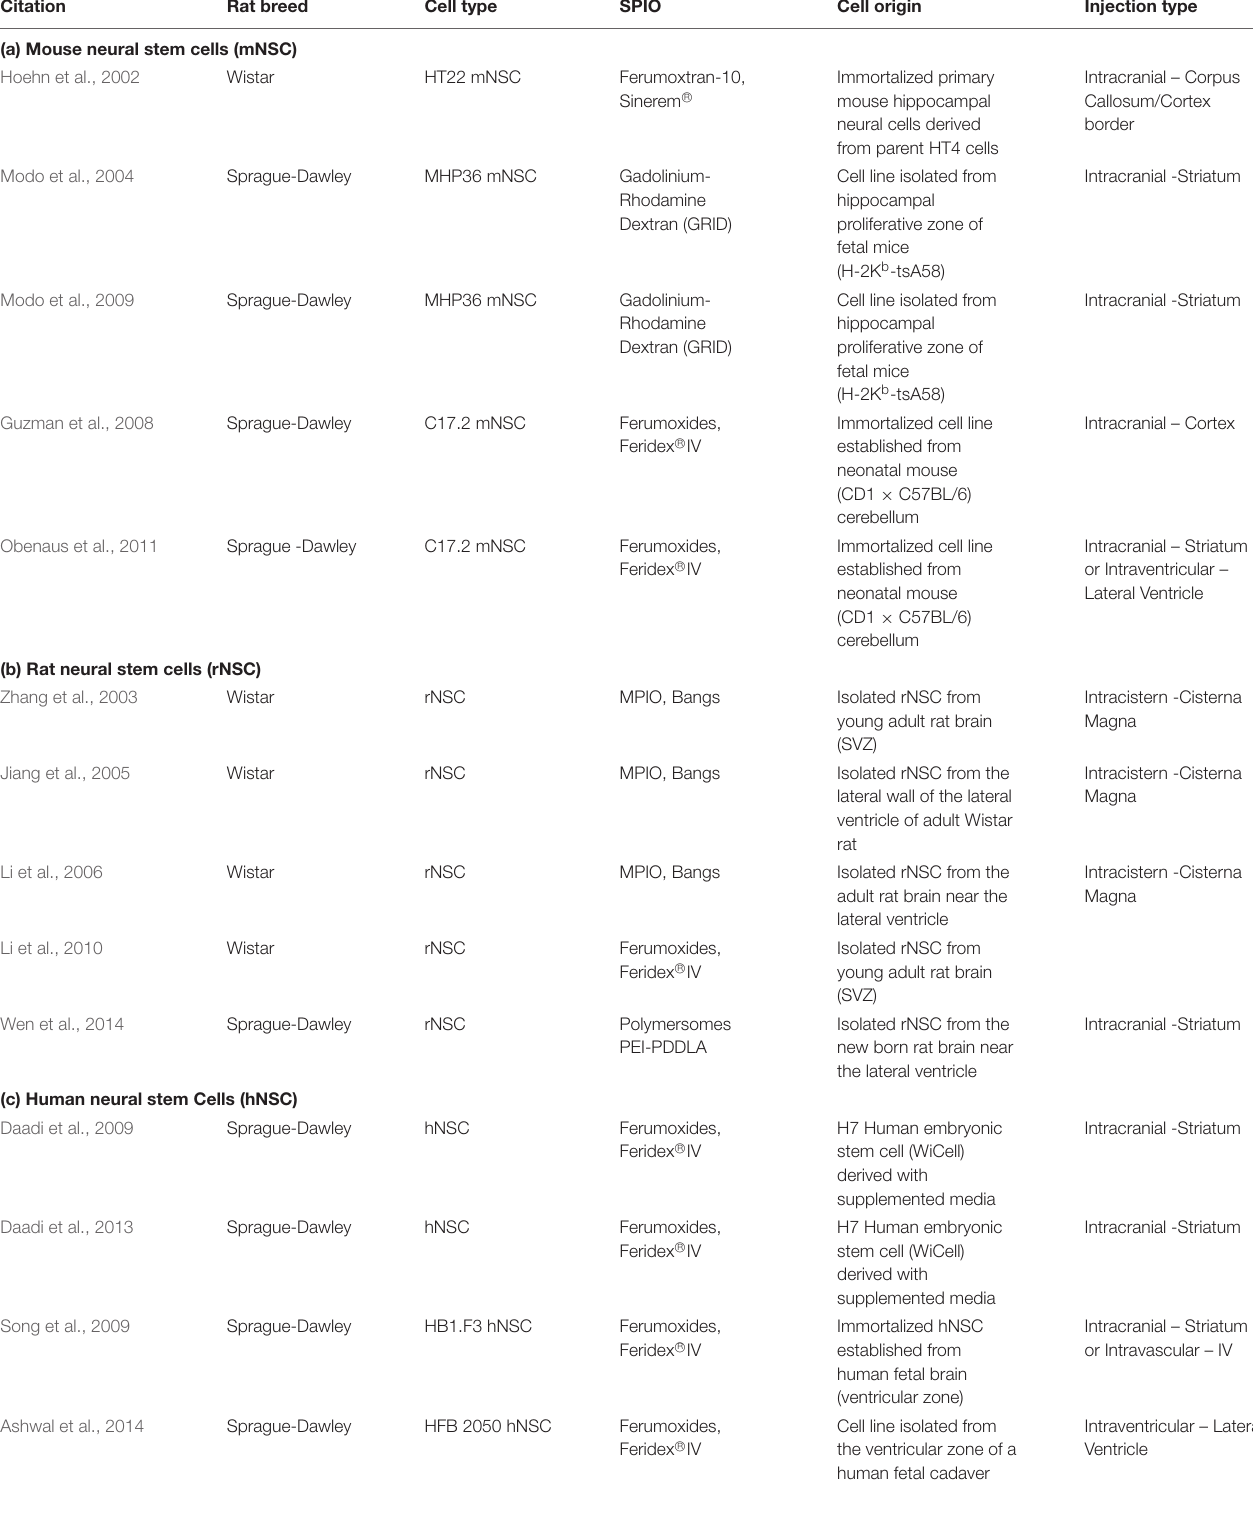
TABLE 2 | Exogenous neural progenitor cells in